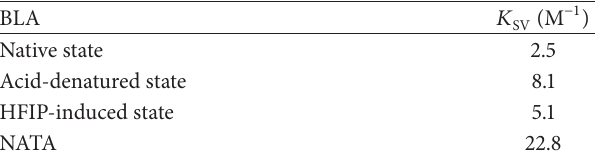
Table 2: Values of Stern-Volmer constant ( 𝐾 formational states of BLA, as obtained from acrylamide quenching data.